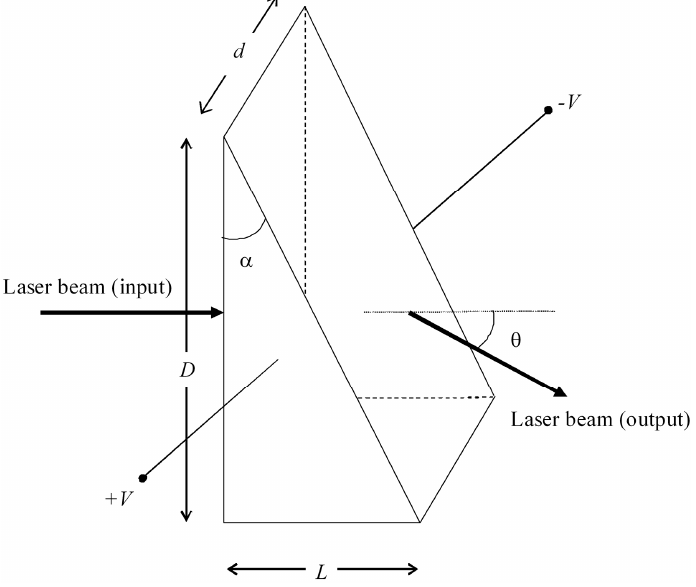
Figure 3. In the electro-optic prism, the deflection angle θ is controlled by the application of a voltage.